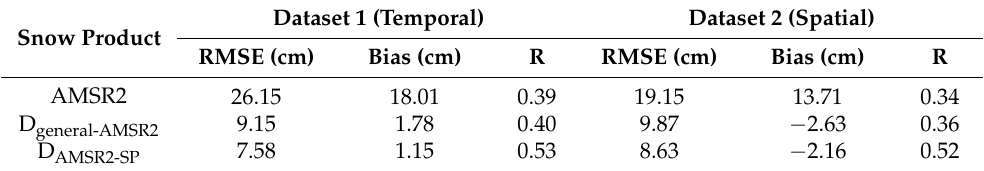
Table 3. Error statistics for the comparison between retrieved SD and observed SD in this